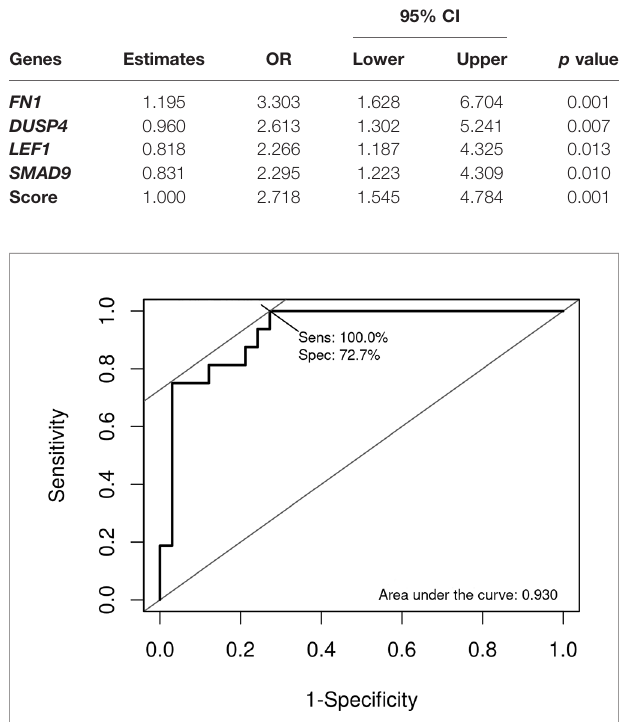
TABLE 3 | Selected genes predicting recurrence in low- and intermediate-risk endometrial cancer. Genes Estimates